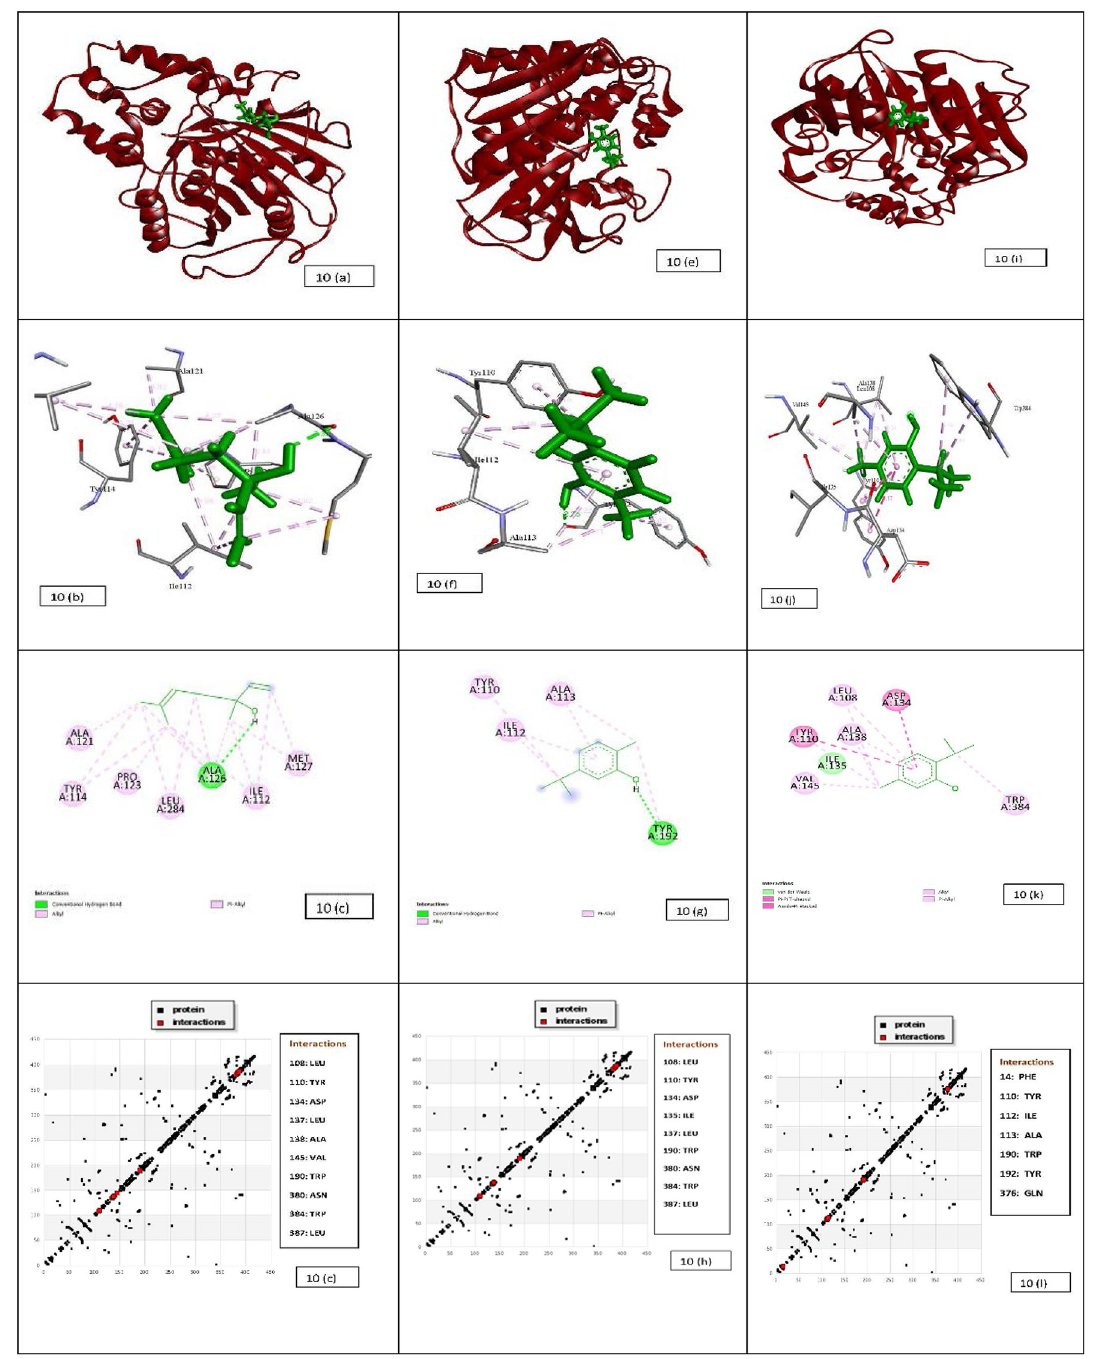
Fig 10. Docking results of lipase-linalool system (a) Structure of lipase showing the subdomain and binding sites of linalool. The lipase is represented as a cartoon. (b) The 2D detailed view shows the interaction between linalool and its neighbouring residues. The green circles are residues participating in hydrogen bonds, charge or polar interactions. The pink circles are residues participating in alkyl and pi- alkyl bonds. (c) The 3D detailed view shows the interaction between linalool and its neighbouring residues Tyr 114, Ile112, Ala 126, Pro123, Leu284, Met127 and Ala 121. (d). HB Plot of linalool in the site of lipase domain. The black dots represent protein and red dots represent interaction. Docking results of lipase-carvacrol system (e) Structure of lipase showing the subdomain and binding sites of carvacrol. The lipase is represented as a cartoon. (f) The 2D detailed view shows the interaction between carvacrol and its neighbouring residues. The green circles are residues participating in hydrogen bonds, charge or polar interactions. The pink circles are residues participating in alkyl and pi- alkyl bonds. (g) The 3D detailed view shows the interaction between carvacrol and its neighbouring